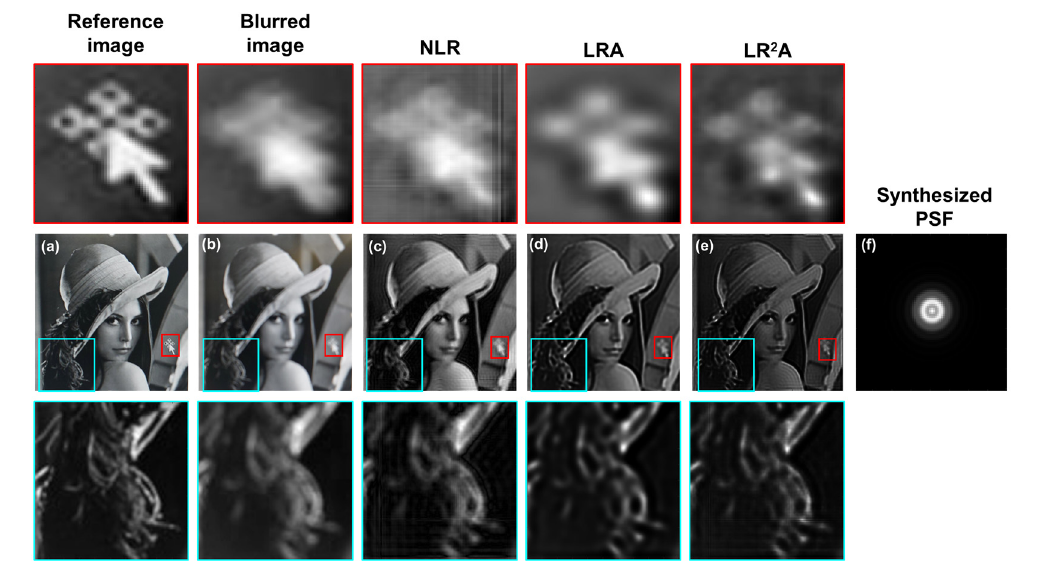
Figure 8. Deblurring of blurred images using NLR, LRA, and LR 2 A using synthetic PSF. ( a ) Reference image, ( b ) blurred image. Deblurring results by ( c ) NLR, ( d ) LRA and ( e ) LR 2 A. ( f ) Synthetic PSF.